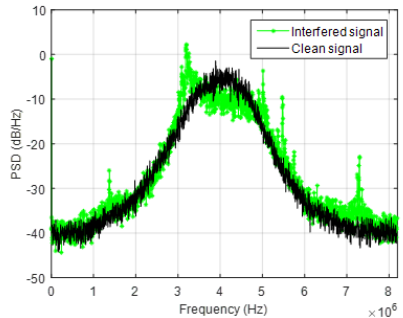
Figure 9. Case-study B. PSD anomaly detected on 7 March 2017 at 11 h:19 m:59 s local time, in Corso Eusebio Giambone, Turin.